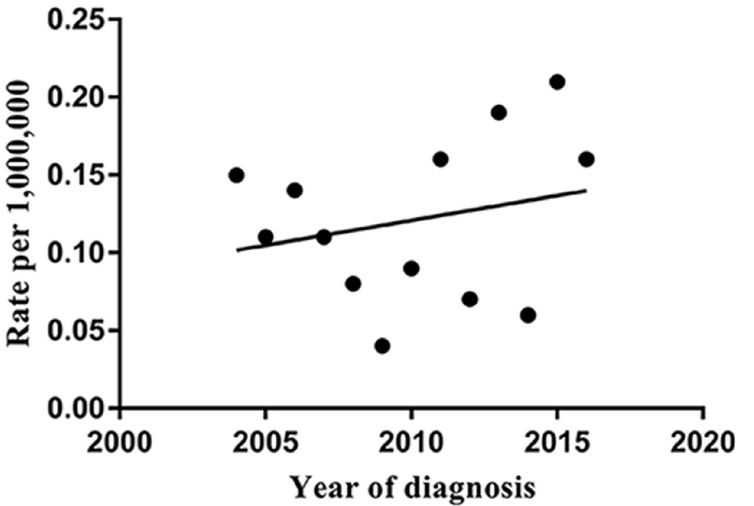
Fig 1. The age-adjusted incidence of pancreatic acinar cell carcinoma during 2004–2016.